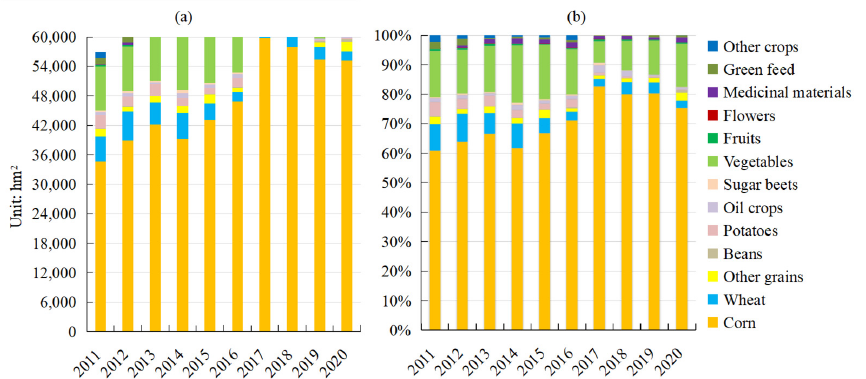
Figure 3. ( a ) Crop planting area and ( b ) proportion of grain crop change in Ganzhou district from